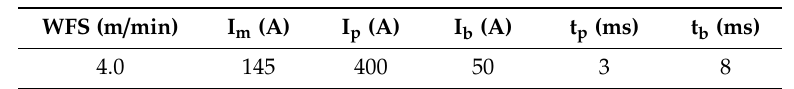
Table 3. Pulsed parametrization for the GMAW process.